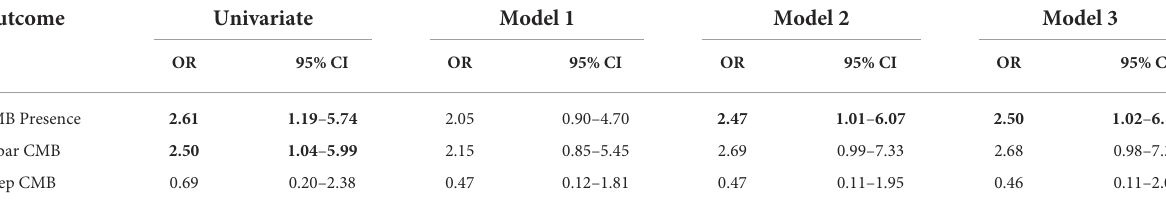
TABLE 2 Multivariable logistic regression models demonstrating the association of atrial cardiopathy with CMB presence, and CMB location, among patients with ischemic stroke ( N = 120). Outcome Univariate Model 1 Model